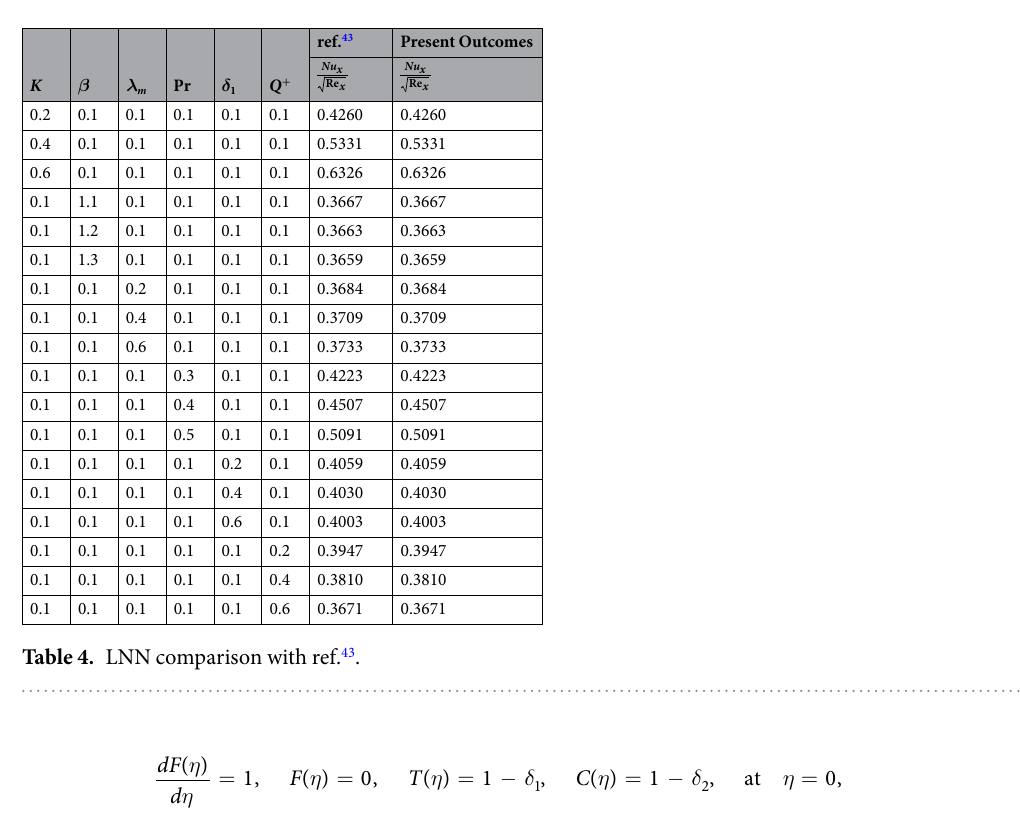
Table 3. LSFC comparison with ref. 43 .